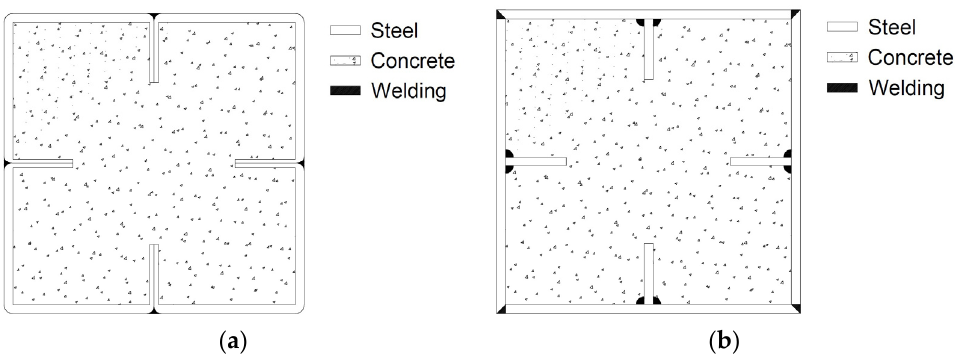
Figure 1. Fabrication of a square tube with stiffeners. ( a ) Lipped fabrication. ( b ) Plate-by-plate fab- rication.